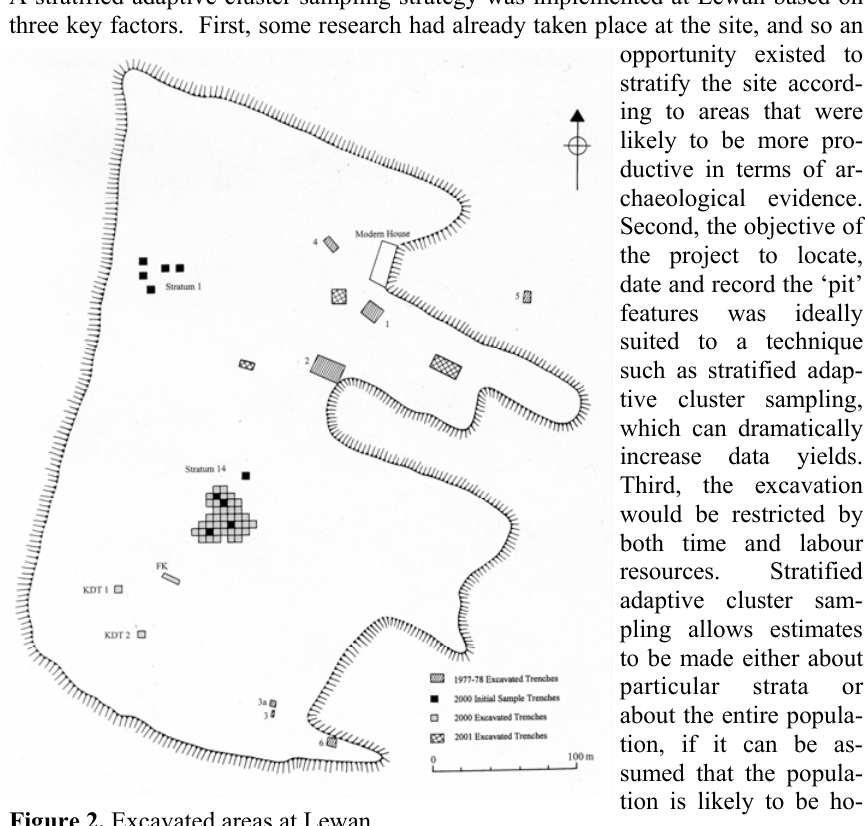
Figure 2. Excavated areas at